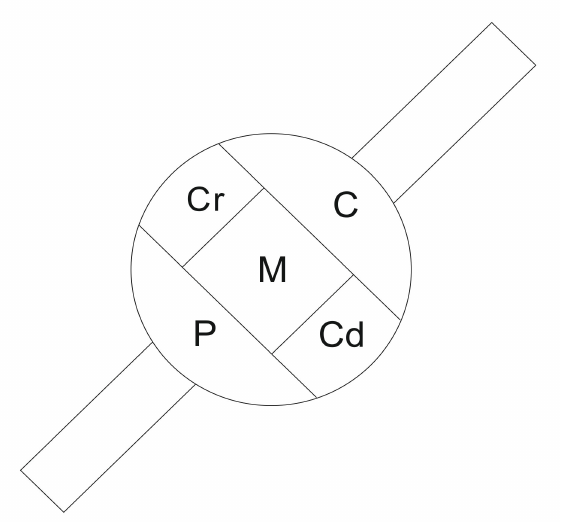
Figure 2. A schematic drawing of a spinal ganglion section showing its arbitrary division into topographical subdomains, in which the occurrence and relative frequency of FB-containing urinary bladder-projecting neurons (UB-PNs) were studied. C—central, P—peripheral, Cr—cranial, and Cd—caudal domains of the DRG, M—middle region of the ganglion. The distribution pattern of FB + cells in the DRGs contralateral to the site of tracer injections was very similar to that seen in the ipsilateral ones: the majority of FB + nerve cell bodies were present in the caudal and cranial subdomains (37.03 ± 2.5% and 33.1 ± 2.4%, re- spectively), with the rest of FB + perikarya dispersed quite evenly in the central, middle, and peripheral regions of the ganglion (10.5 ± 0.6%, 10.8 ± 1.3%, and 8.5 ± 1.4%,